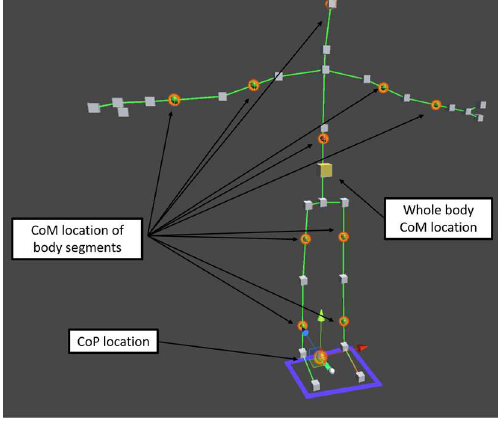
Fig. 6 Body segments CoM locations, whole body CoM and CoP